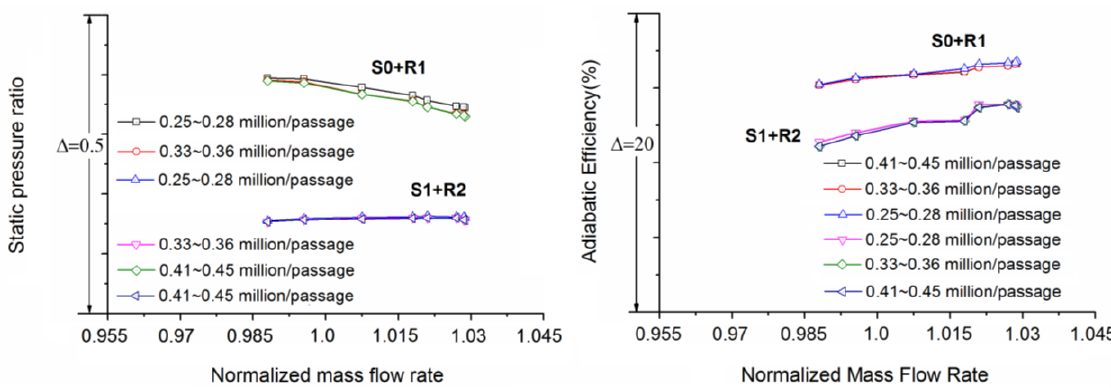
Figure 5. The grid independence Figure 5 . The grid independence analysis . Figure 5 . The grid independence analysis . Table 1. The uncertainty of performance simulation. Table 1. The uncertainty of performance simulation.